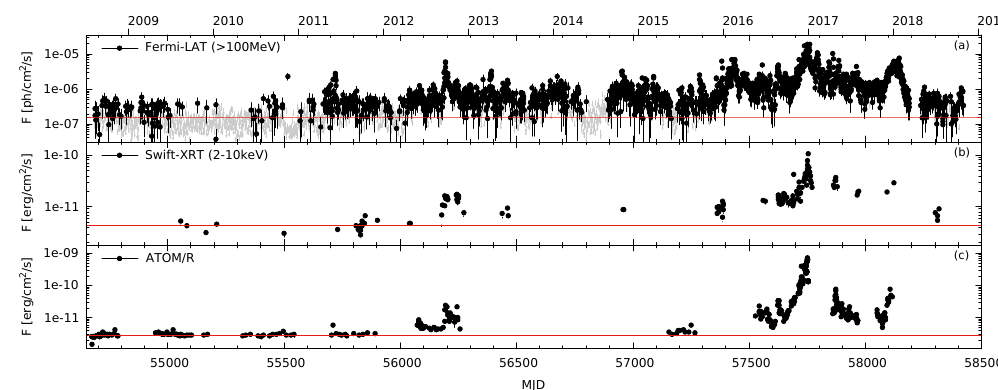
Figure 5. Long-term multiwavelength light curve in daily bins of CTA102 since mid-2008. Note the logarithmic scaling of the y-axis. The gray arrows mark upper limits and the red lines the pre-2012 averages